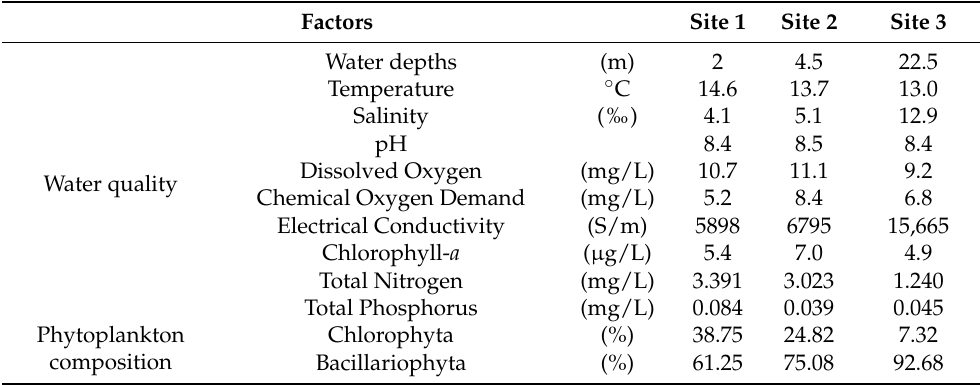
Table 1. Summary of environmental characteristics—water depths, water quality variables and phytoplankton community composition—at each study site.